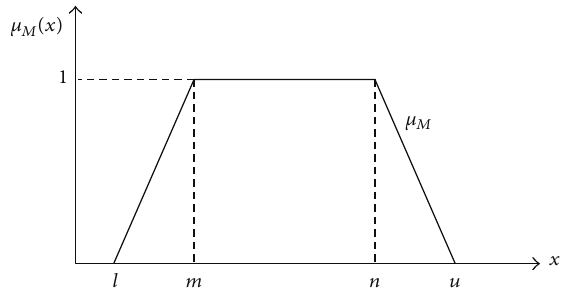
Figure 1: Trapezoidal fuzzy number 𝑀